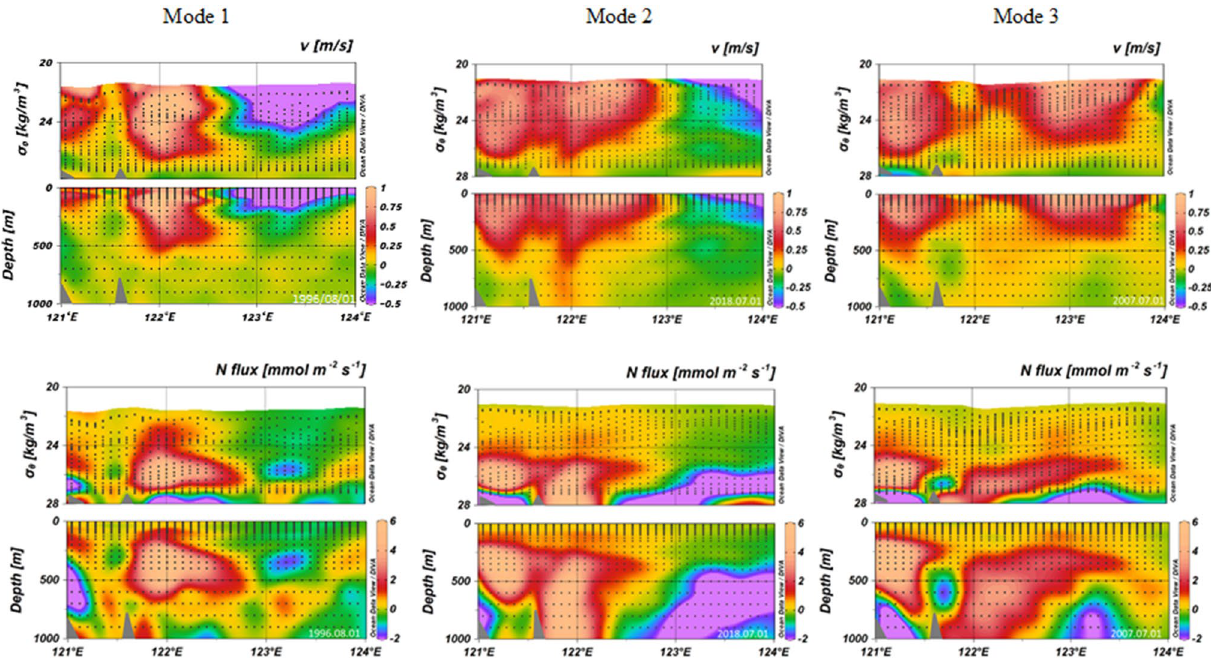
Figure 2. Typical northward velocity and N fluxes for Mode 1, 2, and 3